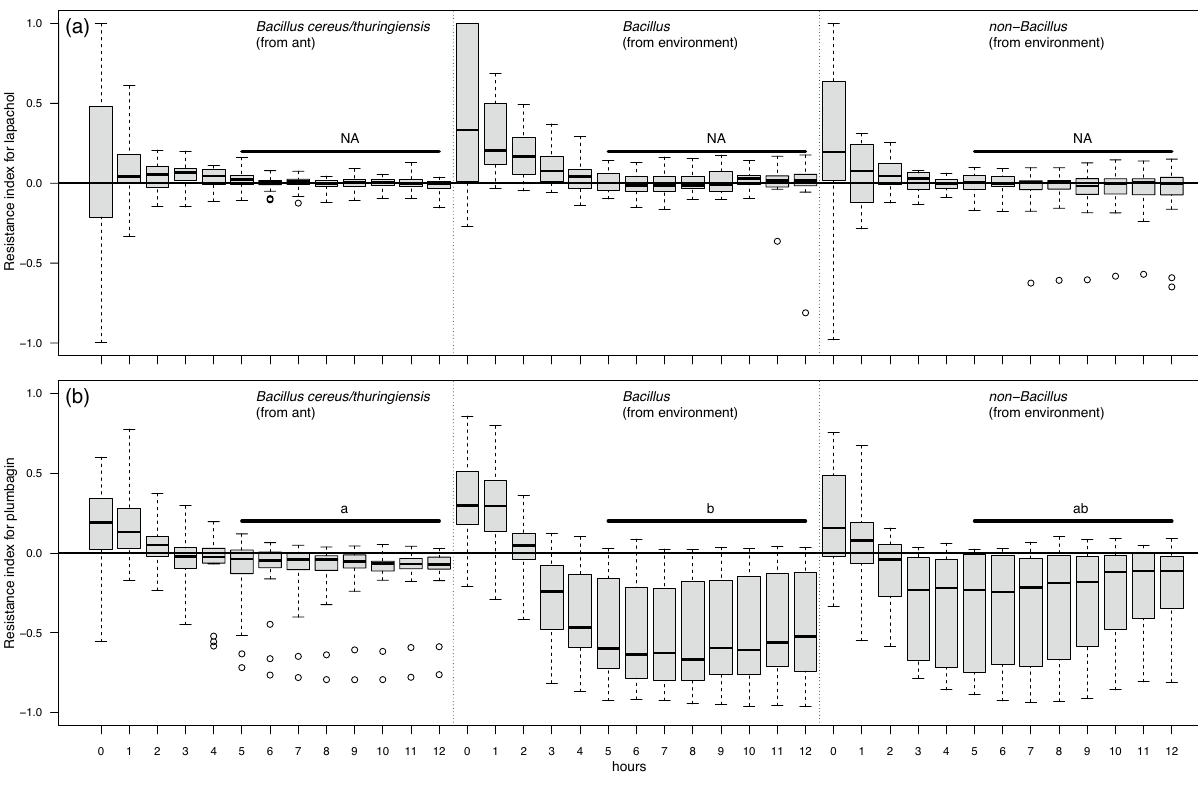
Figure 5. The resistance index of bacterial growth in the presence of two naphthoquinones, lapachol ( a ) and plumbagin ( b ). Letters indicate significant pairwise differences between Bacillus cereus / thuringiensis isolated from ant cadavers of Polyrhachis moesta , Bacillus isolates from the environment, and non- Bacillus isolates from the environment (Tukey’s all-pair comparisons using the linear mixed model, p <